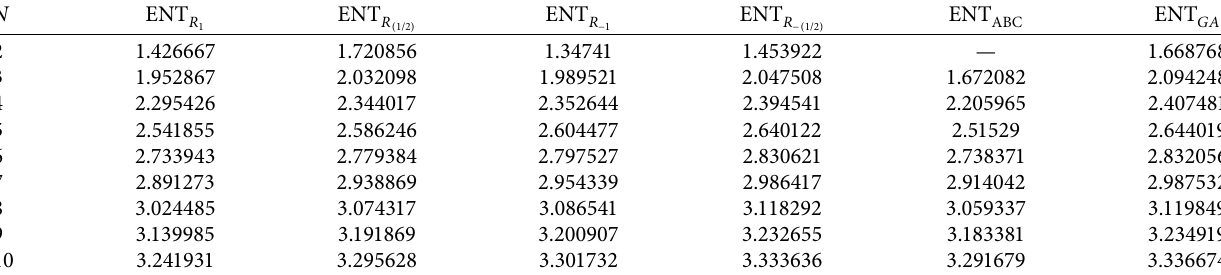
Table 5: Comparison table of entropies for HDN 1 ( n ) .